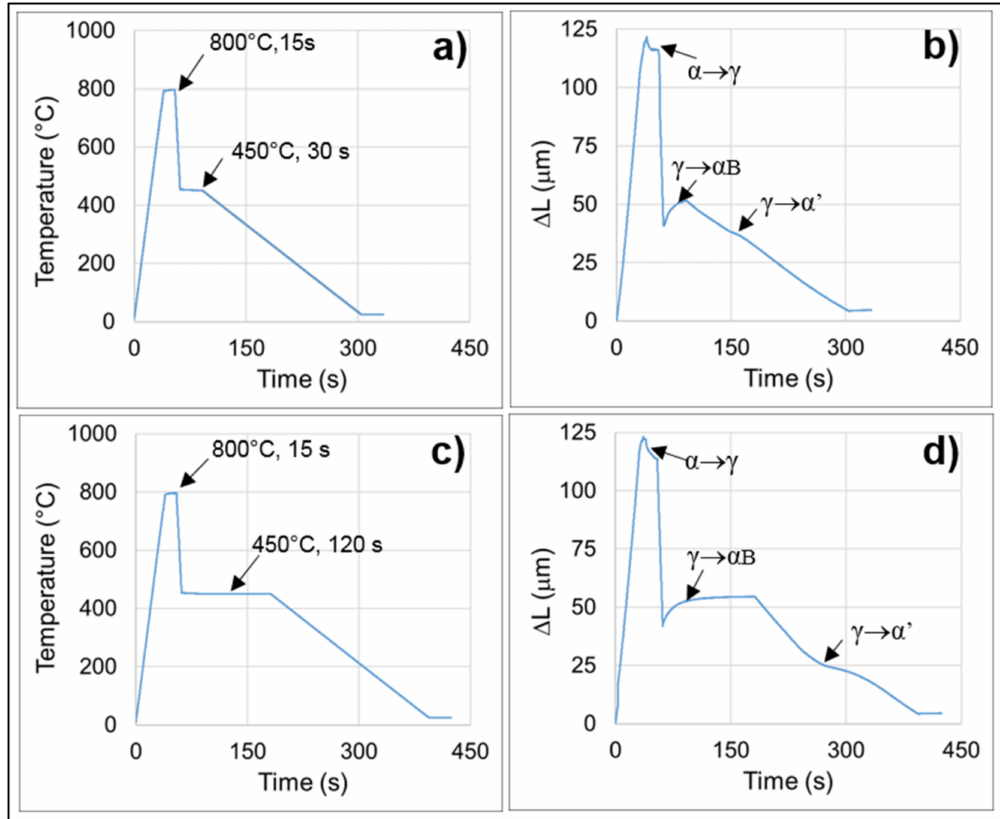
Figure 6. ( a , c ) Experimental temperature vs time plots and ( b , d ) dilation vs. time